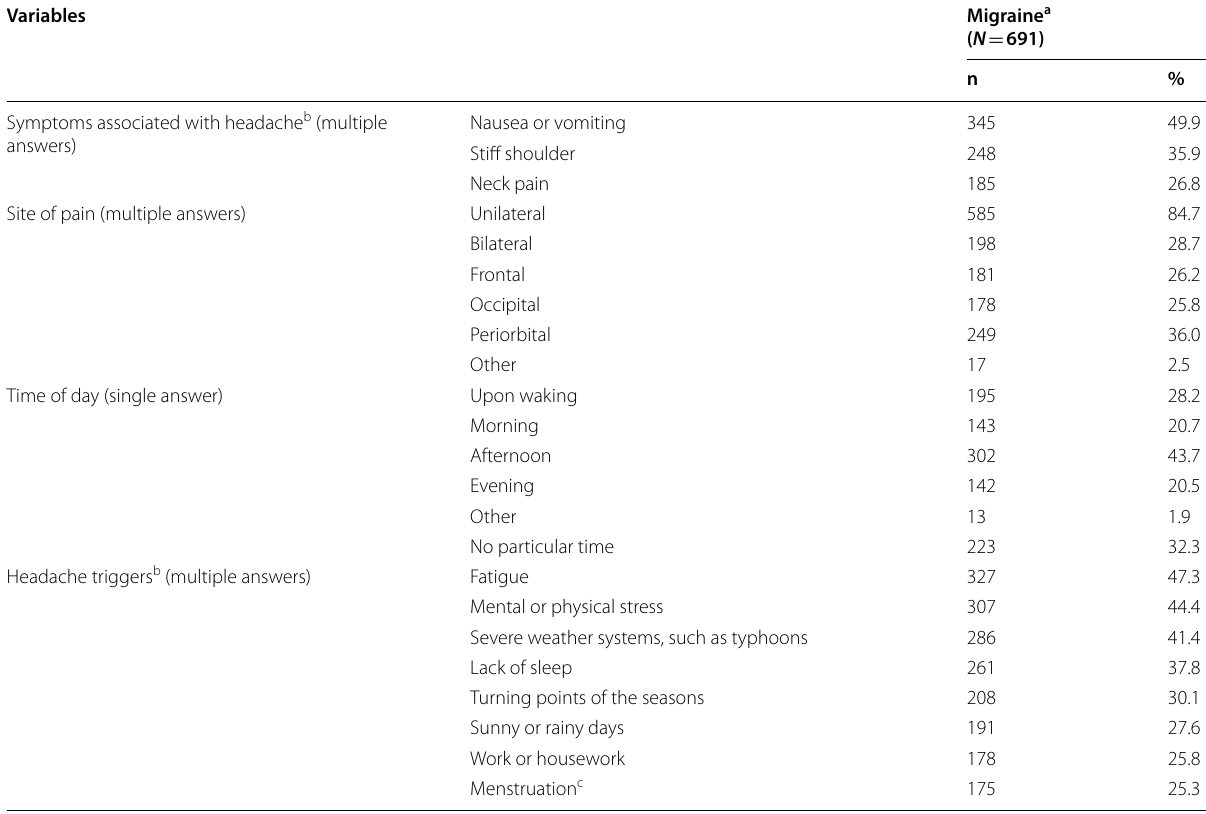
Table 4 Symptoms and triggers of migraine